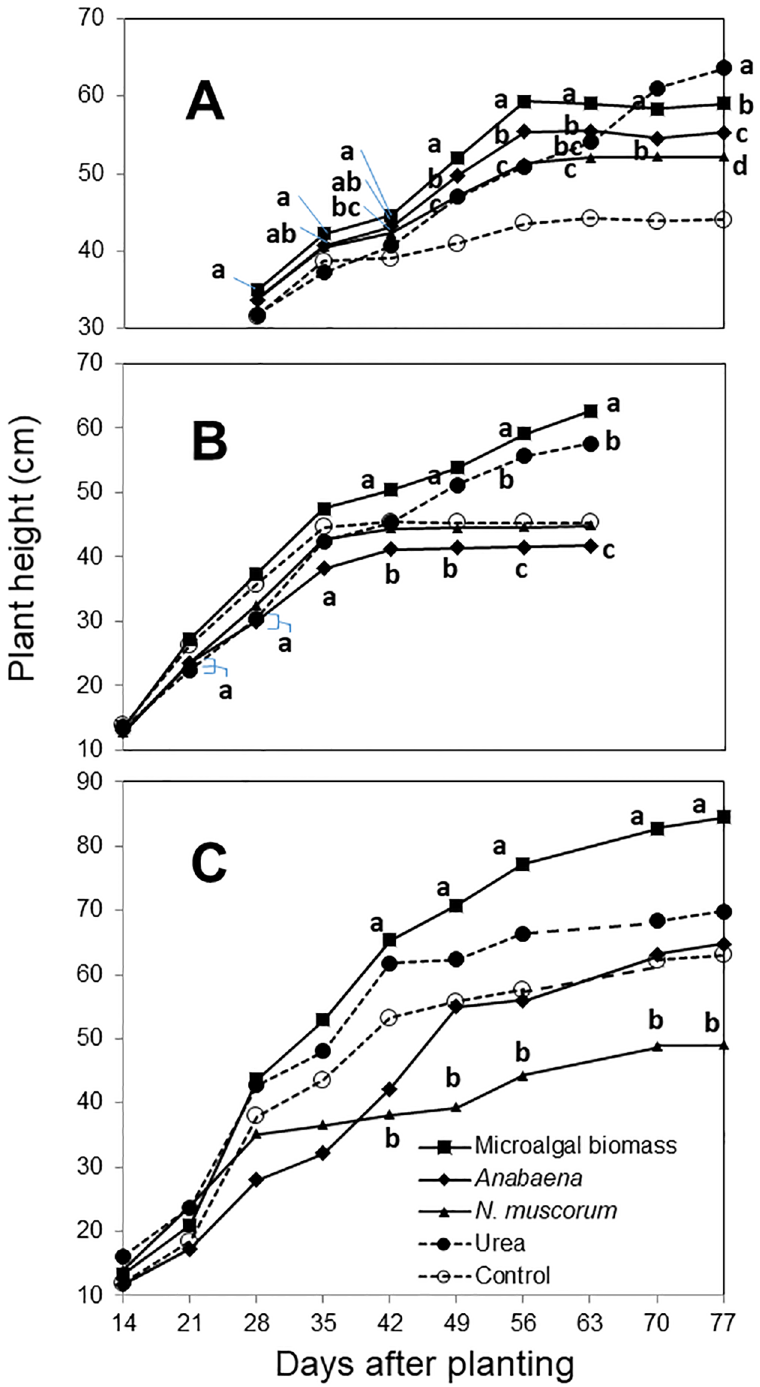
Fig 3. Time-course effect of four different fertilization treatments on the rice plant height under greenhouse conditions. Live inoculum of N 2 -fixing cyanobacterial strains applied was a mixture of Anabaena sp. UTEX 2576 and Nostoc muscorum UTEX 2209S. Microalgal biomass was a polyculture of Chlorella vulgaris and Scenedesmus dimorphus . Treatments with the same letter at the same day after planting are not significantly different according to Fisher’s protected leas significant difference (LSD) test at P = 0.05. The letters are presented only for the treatments significantly different from the non-treated control. Exp 1 (A), Exp 2 (B) and Exp 3 (C).